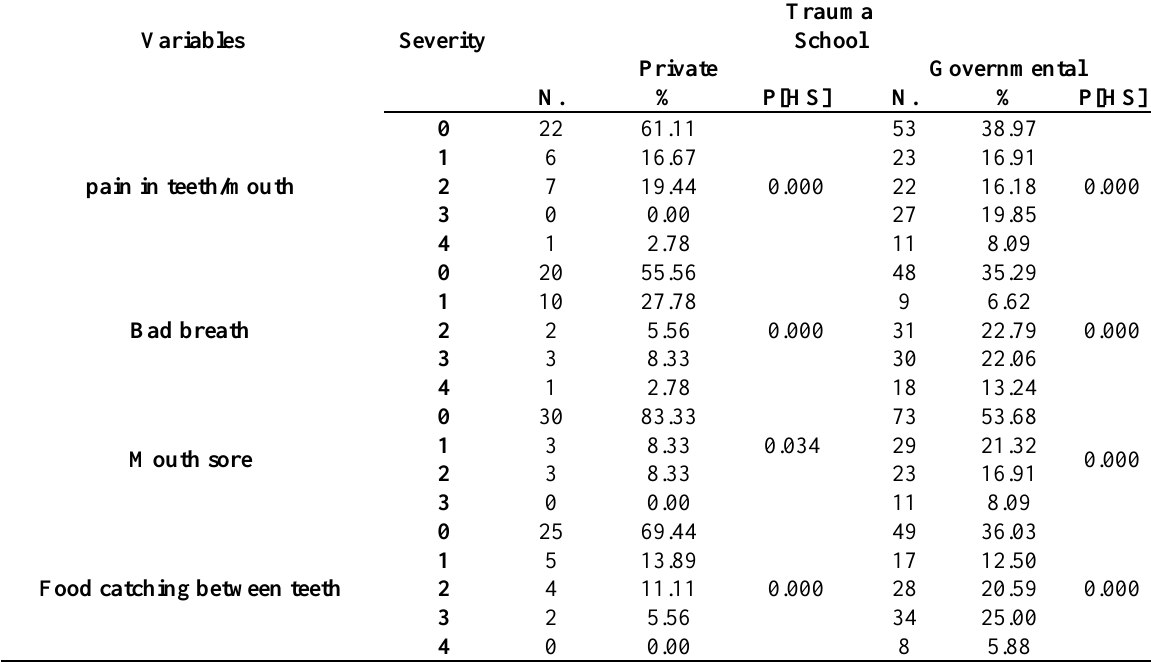
Table (4a): The association of traumatic dental injuries and quality of life regarding oral symptom by school types.